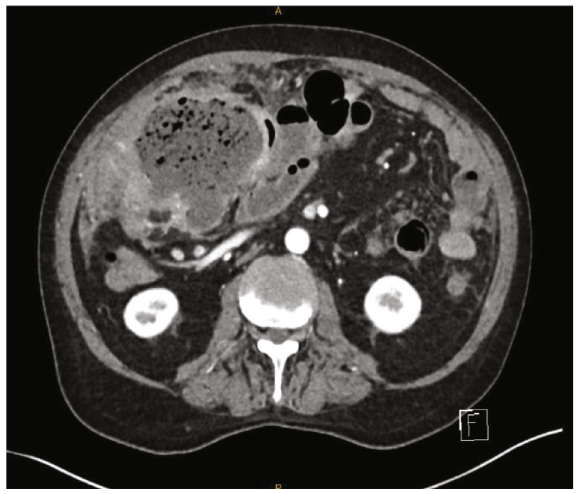
Figure 2: Pre-operative axial CT angiogram revealing relationship of the faecaloma to the ileocolic